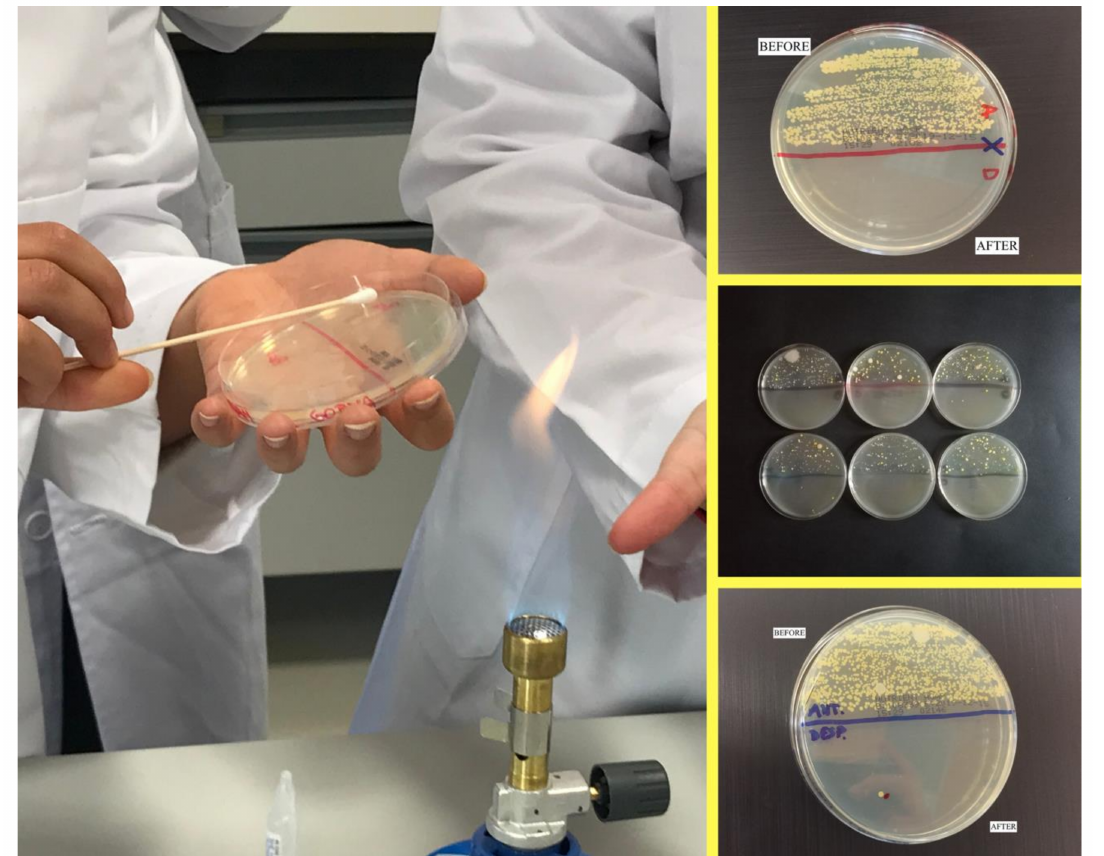
Figure 2. Description of the intervention and data